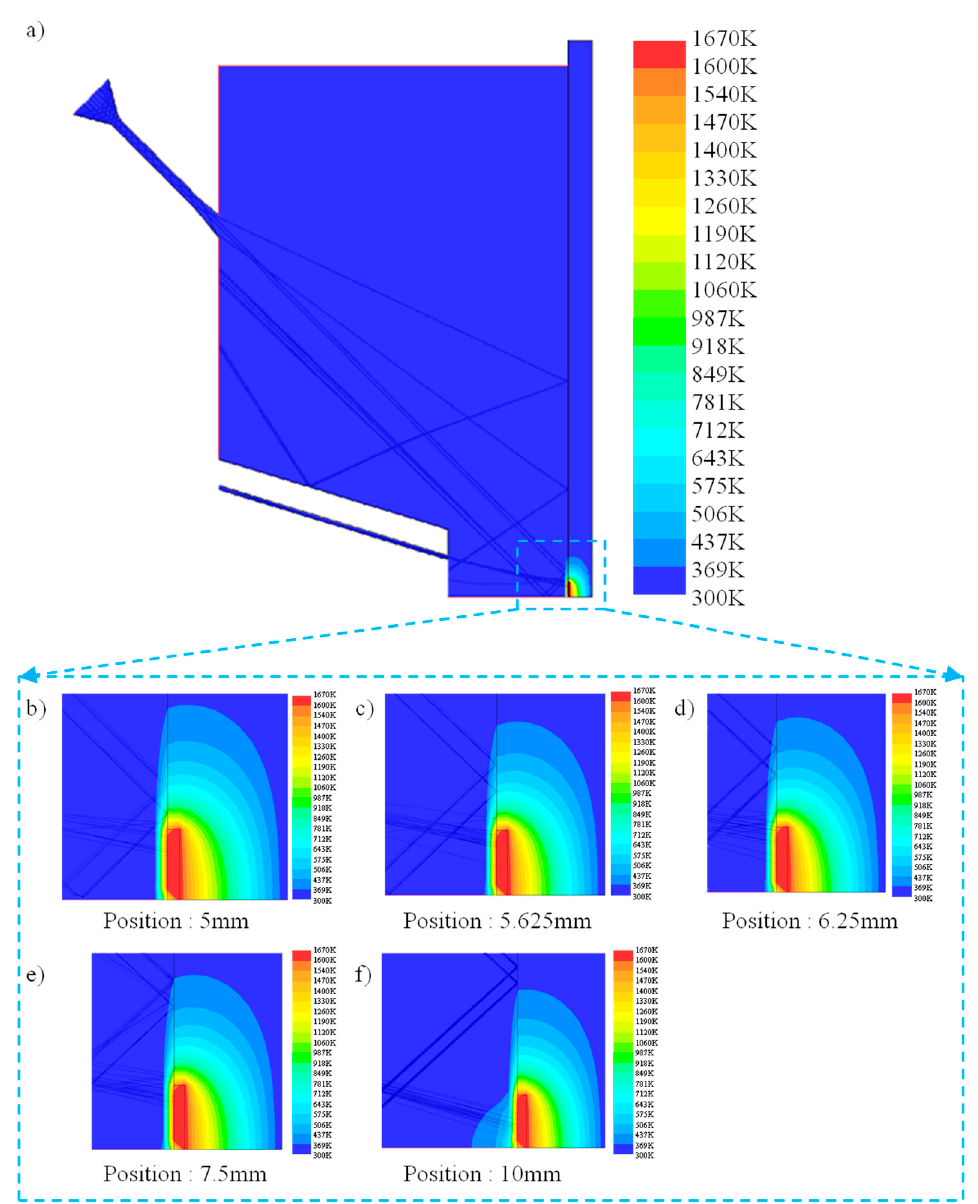
Figure 4. Temperature field distribution and powder trajectory near the injection point. ( a ) Overall schematic diagram and ( b–f ) particle track and temperature field changes at different shot positions.